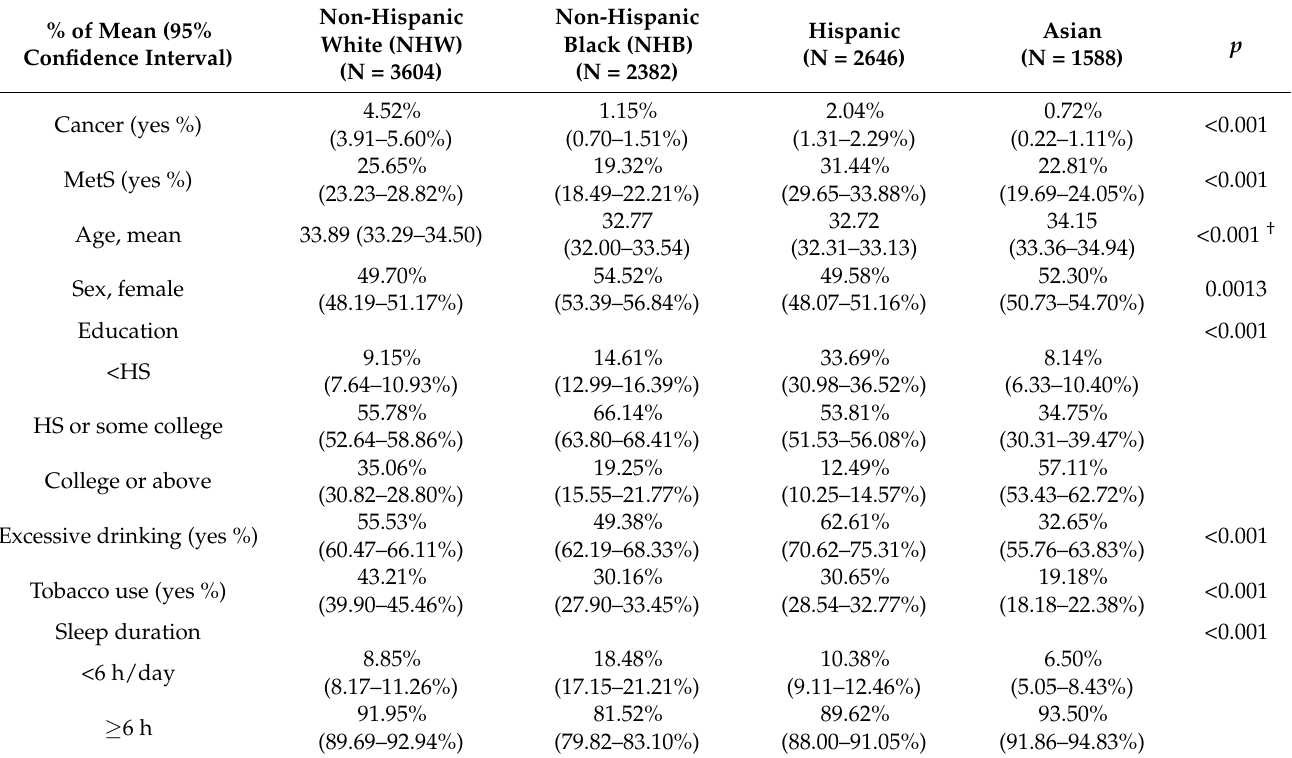
Table 1. Weighted Descriptive Statistics by Race/Ethnicity, NHANES 2011–2016 (N =